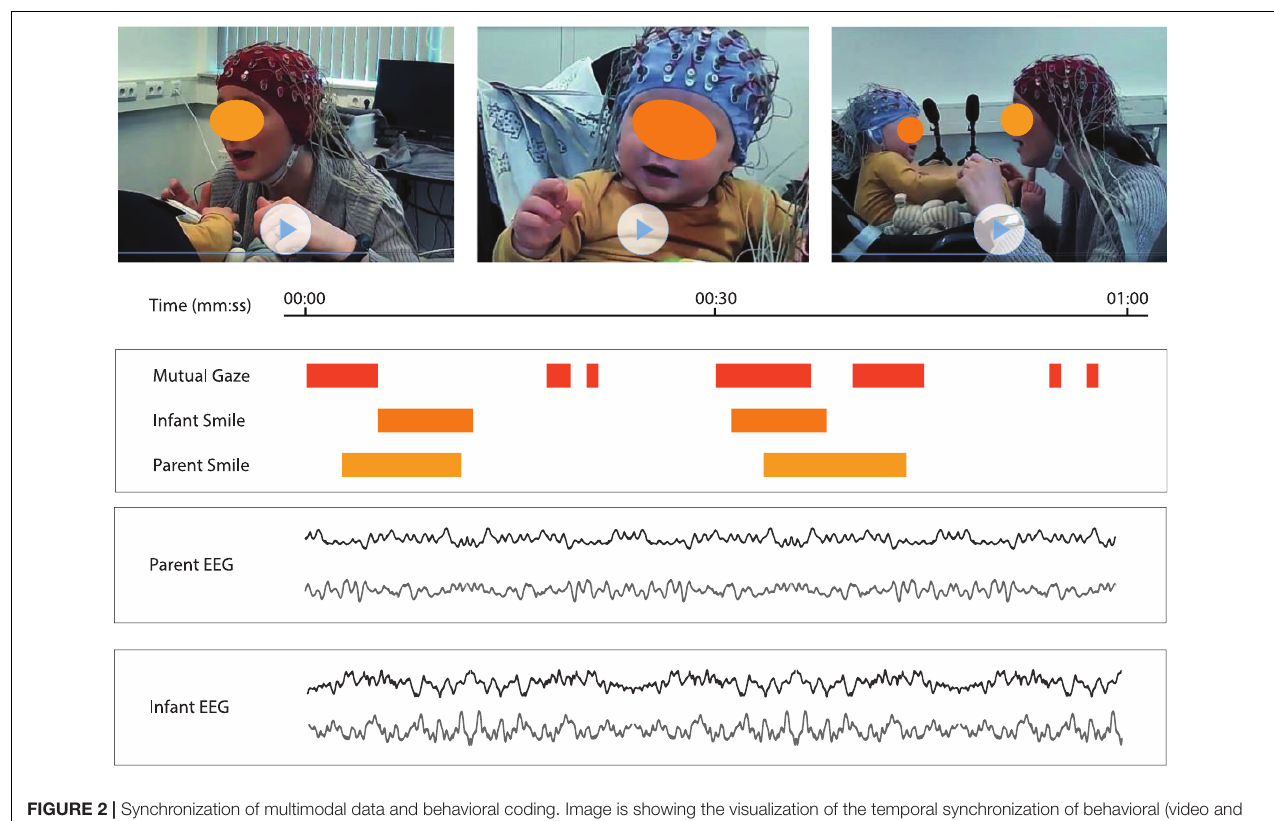
FIGURE 2 | Synchronization of multimodal data and behavioral coding. Image is showing the visualization of the temporal synchronization of behavioral (video and coding) and neural (EEG) data from (a fabricated) parent–infant EEG session of 1-min-interval. On (Top) , three videos are displayed with mom-view, infant-view and overview. (Middle) Timeline and behavioral coding for mutual gaze, infant smile and parent smile are displayed. Color (orange/yellow) represents the existence of the behavior and white represents the absence of the behavior. (Bottom) EEG signal of two parent electrodes and two infant electrodes are